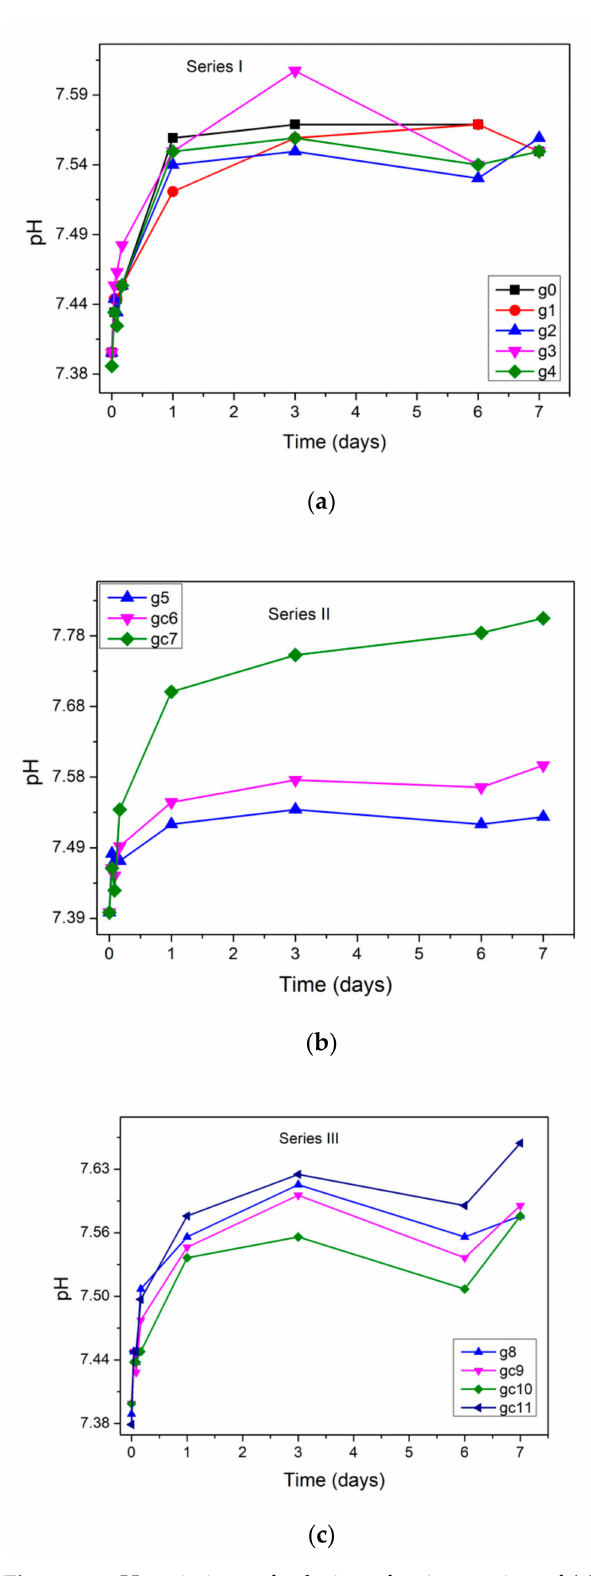
Figure 5. pH variations of solution after immersion of ( a ) series I, ( b ) series II, and ( c ) series III samples in SBF up to 7